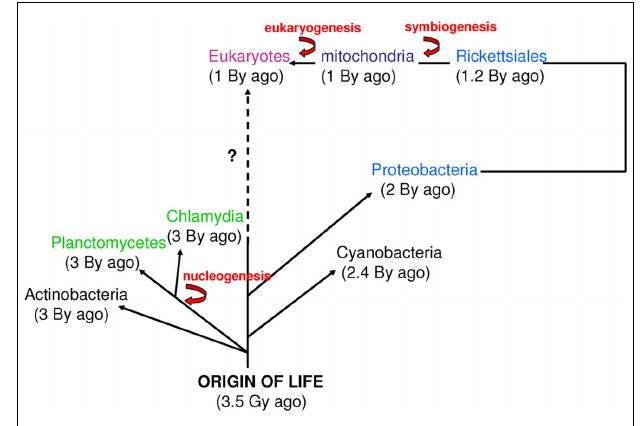
FIGURE 2 |Time scale of eukaryogenesis and nucleogenesis. Eukaryotes are not the only species with compartmentation. First eukaryotes emerged from an endosymbiotic event.The first nucleus appeared approximately 3 billion years ago in Planctomycetes and Chlamydia .These numbers are approximations (Bromham and Penny, 2003; Cavalier-Smith, 2004;Trevors and Abel,